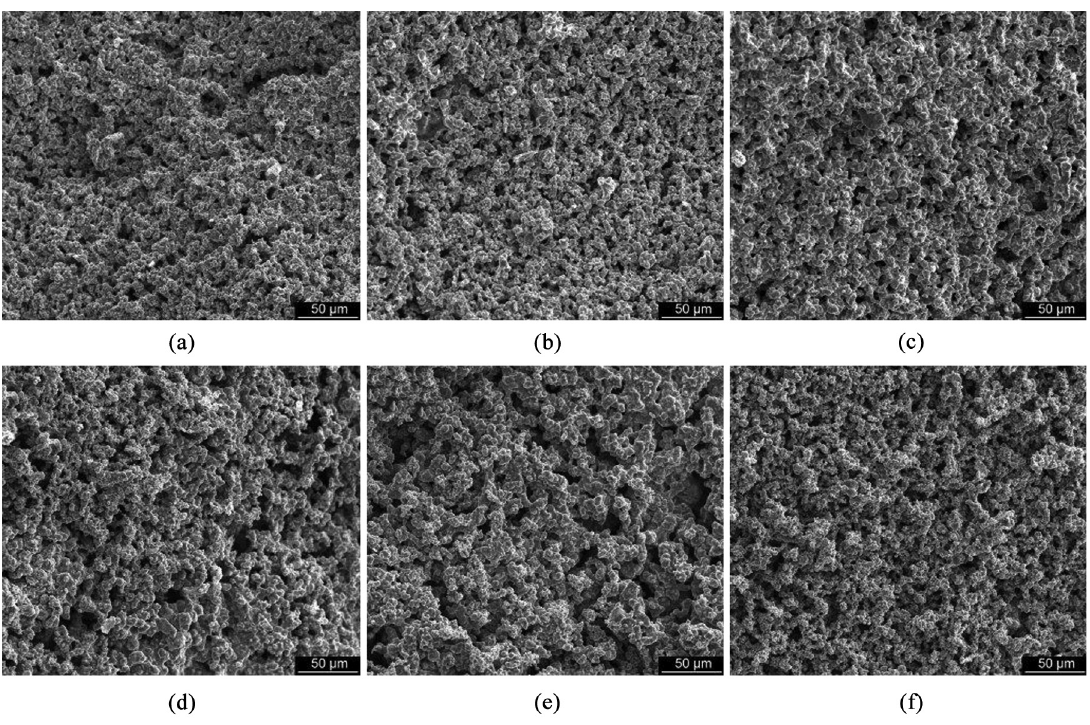
Figure 8. SEM micrographs of the combustion synthesis products, 0 # (a), 1 # (b), 2 # (c), 3 # (d), 4 # (e) and 5 # (f). Table 2. The density, crystal structure and lattice parameters of MoSi